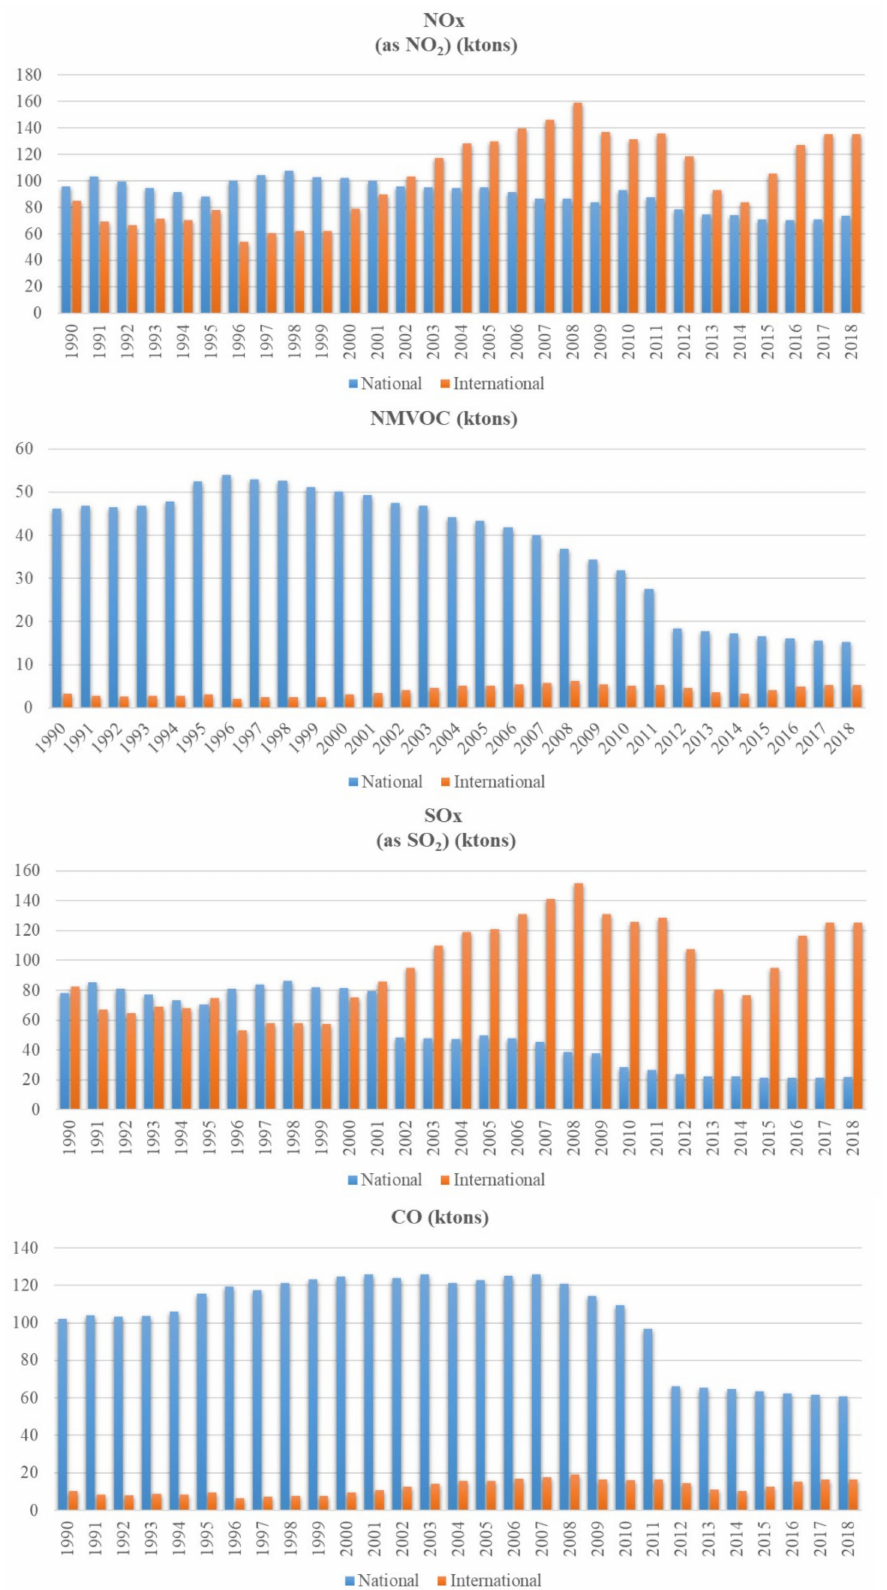
Figure 3. Gaseous emissions of national and international shipping, reported in the Italian emission inventory in the 28-year period 1990–2018. Data from ISPRA elaborations